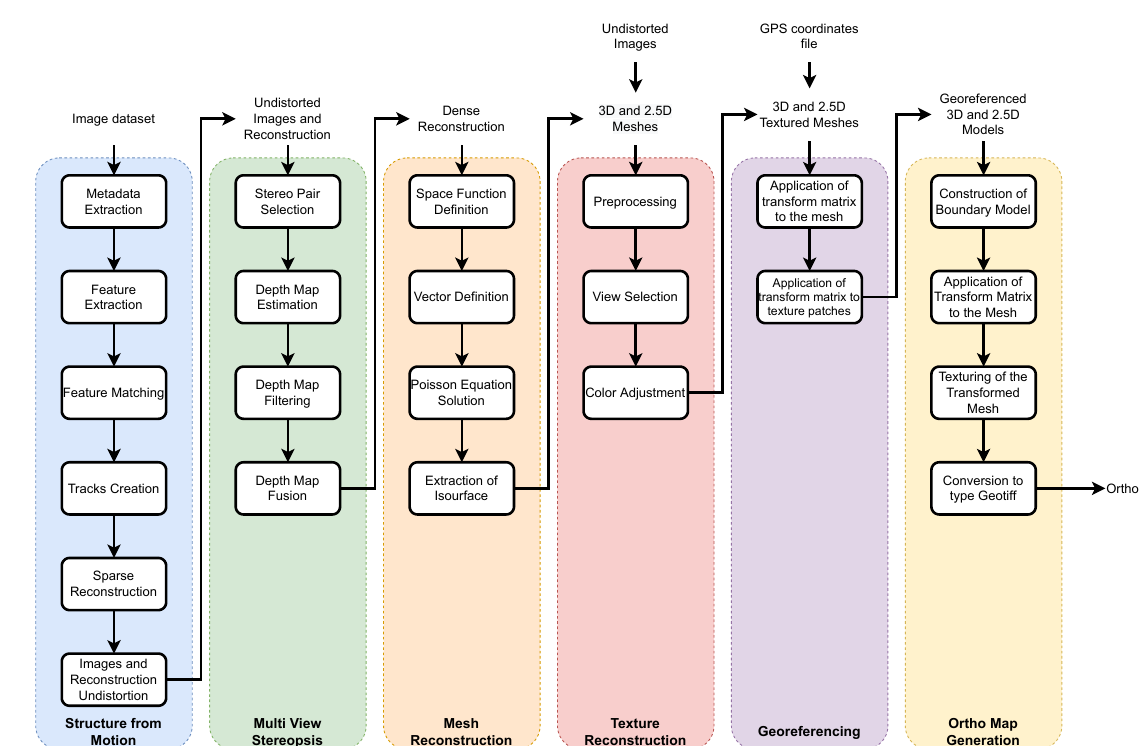
Figure 4. Step-by-step representation of the methodology